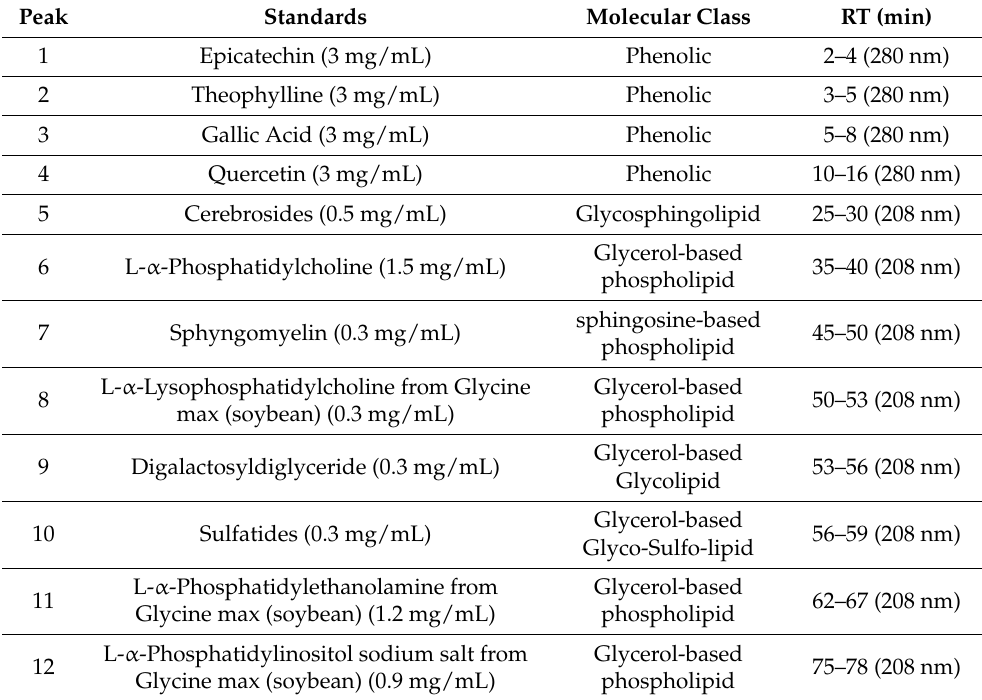
Figure 1. Representative Chromatogram of standards analysed by the HPLC method in 208 nm (Polar Lipids) and 280 nm (Phenolic compounds). Abbreviations: PC: Phosphatidylcholine; SM: Sphyngomyelin; PE: Phosphatidylethanolamine; PI: Phosphatidylinositol; SF: Solvent Front; A: Acetonitrile; B: Methanol; C: Water. Table 1. Retention Times (RTs) of Individual Standards assessed during